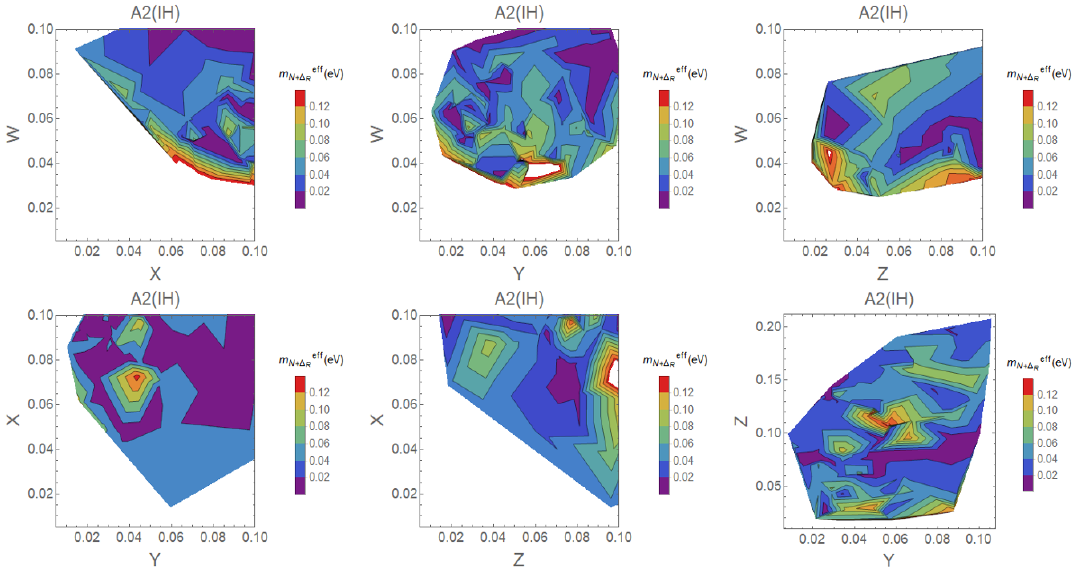
JHEP02(2019)129